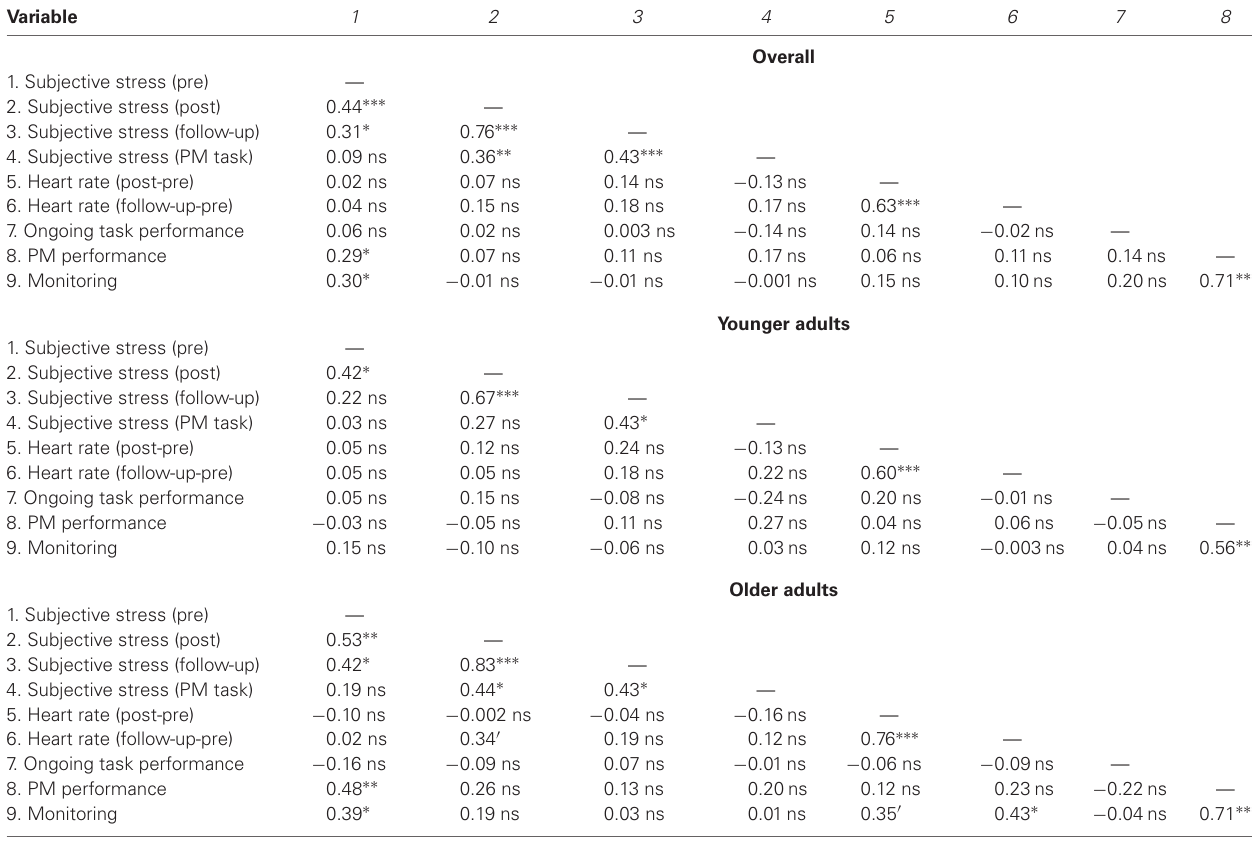
Table 1 | Correlations between measures .